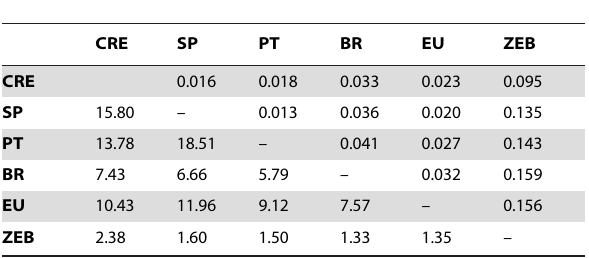
Table 2. Genetic distances among breed